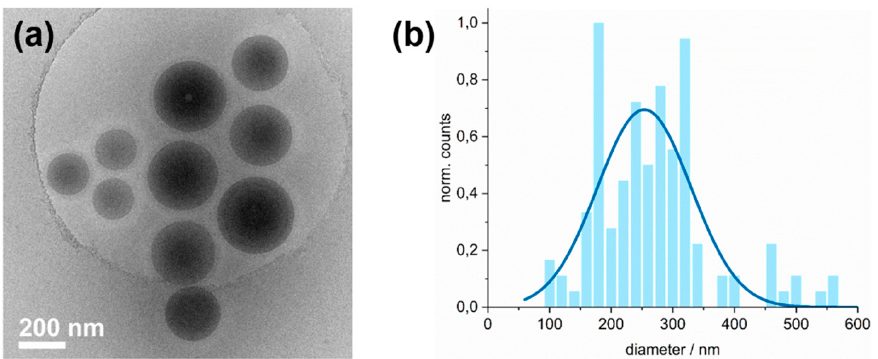
Figure 11. ( a ) Exemplary cryoTEM micrograph of the diluted P(DMA 35 -NIPAM 212 )-PS 1089141 dispersion. Only the dense micelle core is visible in the micrographs due to the low contrast of the swollen corona against amorphous ice. The polymer dispersion was diluted with MILLI-Q ® water to obtain a final latex concentration of c = 0.2% ( w / w ). ( b ) The histogram shows the size distribution of latex particles taken from the analysis of cryoTEM micrographs of the sample. A Gaussian fit (blue line) revealed a mean diameter of 254 ± 152 nm. For the analogous room-temperature TEM micrograph and size distribution, see Figure S3.